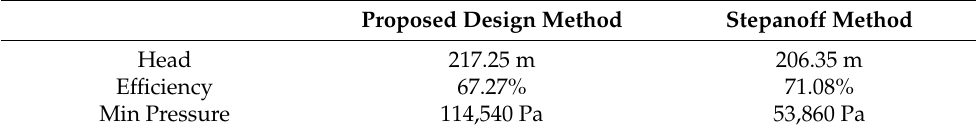
Table 5. Performance of pumps obtained using different design methods.